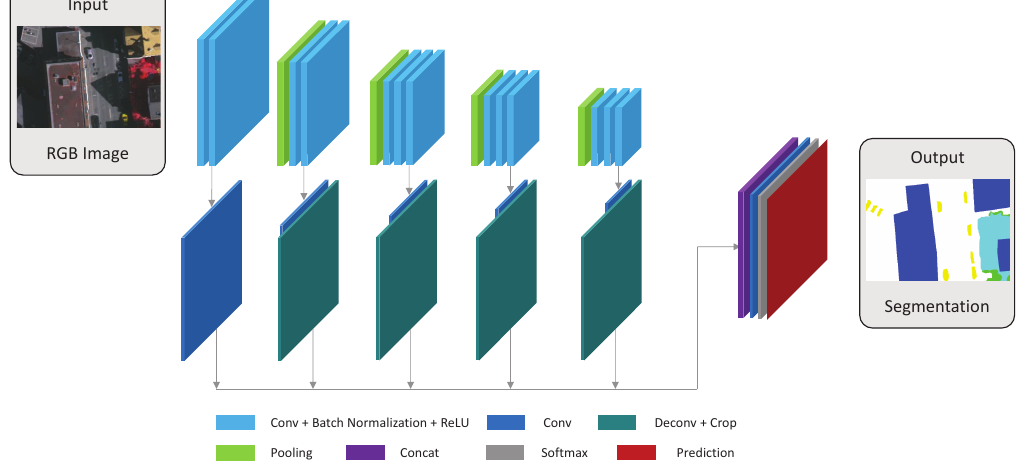
Figure 2. An illustration of our proposed pixel-to-pixel architecture. There are no fully connected layers in our architecture, only convolutional